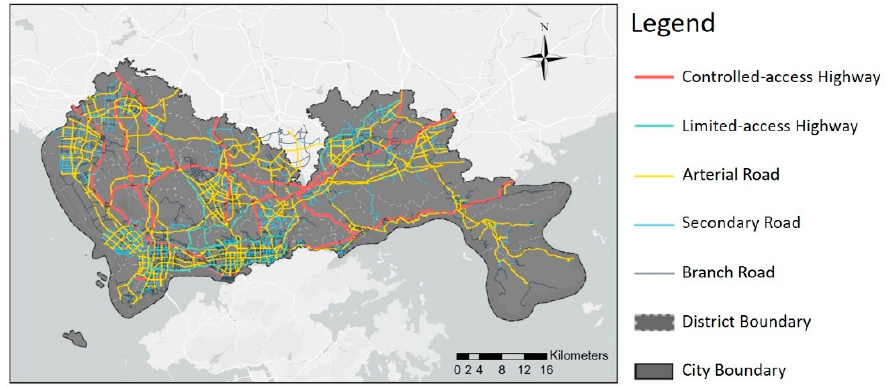
Figure 3. Road network structure of Shenzhen (the source of the geographical background is Mapbox).